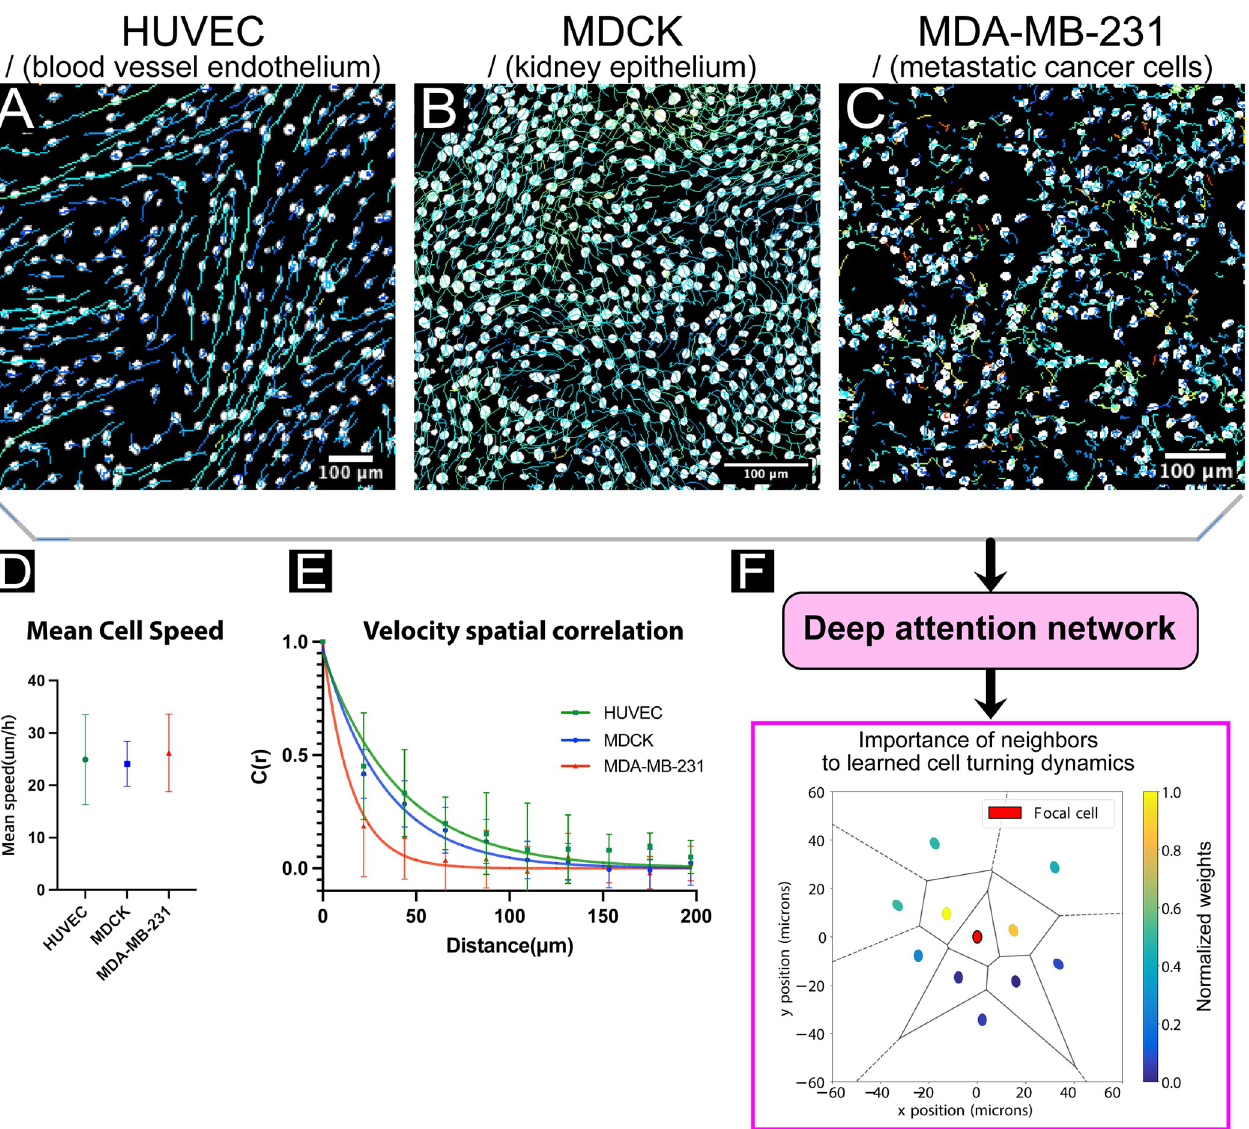
Fig 1. Cell trajectory data reveals collective rules. (A, B, C) Representative cell trajectories within living tissues, from human umbilical vein endothelial cells (HUVEC), Madin-Darby Canine Kidney cells (MDCK), and epithelial, metastatic human breast cancer cells (MDA-MB-231), respectively. All three cell lines exhibit visually distinct dynamics: the HUVECs tend to have strongly correlated and directed leader/follower behavior; while MDCKs exhibit more complex coordination patterns and lack the directedness of HUVECs (e.g. see [23]); and the MDA-MB-231’s lack coordination with neighbors. Scale bars are 100 μ m. See S1–3 Movies. (D) Classical collective analysis techniques reveal some group characteristics, such as mean speed or (E) velocity cross-correlations. (F) Deep attention networks trained on cell trajectory data can directly reveal new types of collective information, such as the learned relative influence of neighboring cells to forward motion of a focal cell. Here, the agents in front of the focal cell have higher weights, W (see Eq 1), with relative directions determined by agent trajectories. Cell position is representing using nuclei centroids and black lines indicate Voronoi cells (see Methods